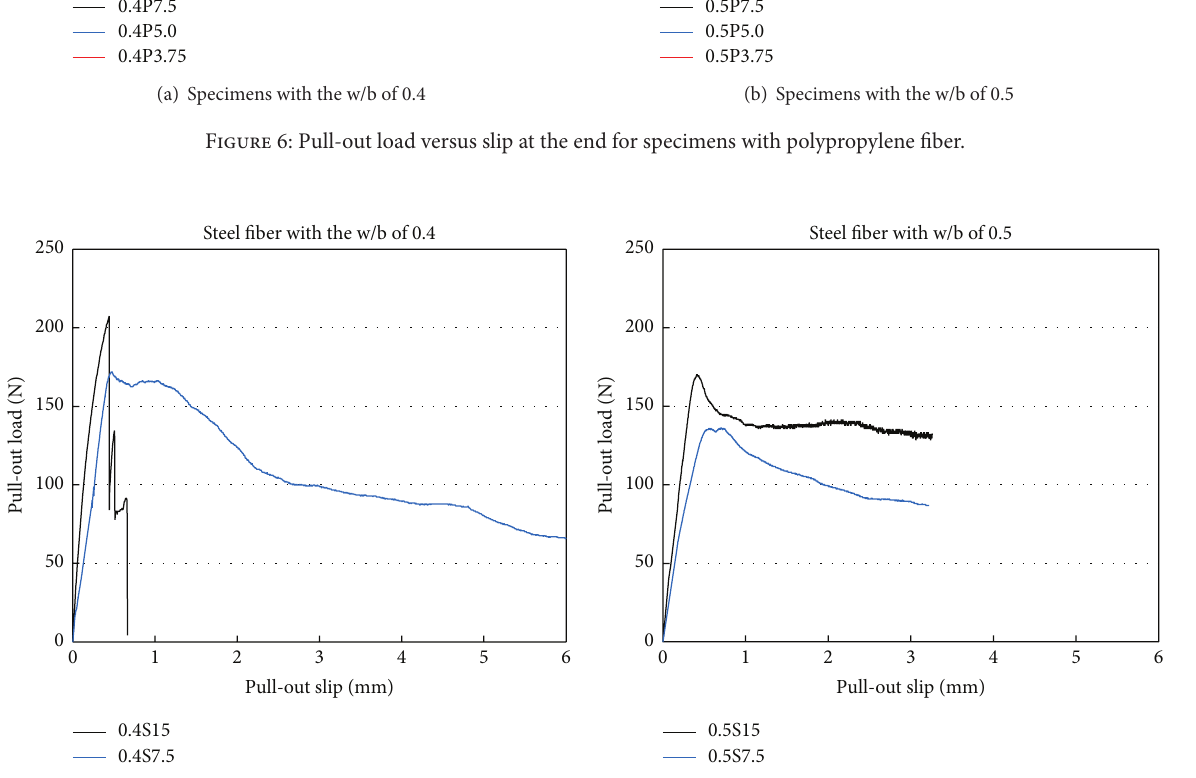
Figure 7: Pull-out load versus slip at the end for specimens with steel